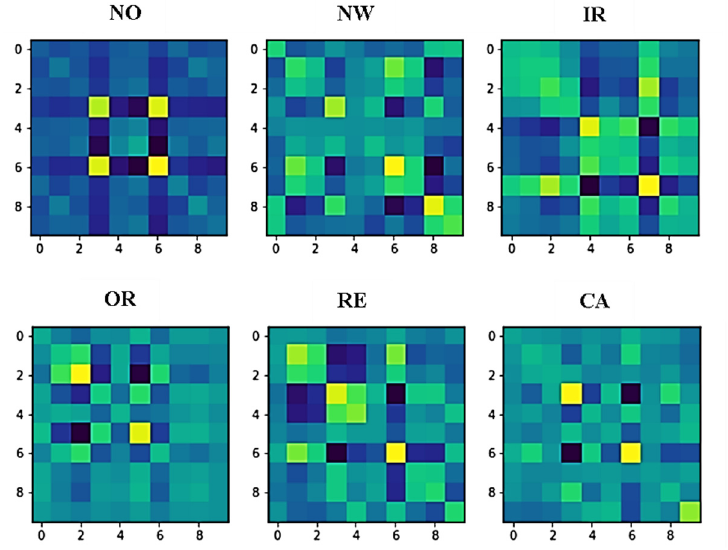
Figure 9. Examples of the generated vibration image using the MTF technique for bearing vibration with six health conditions.